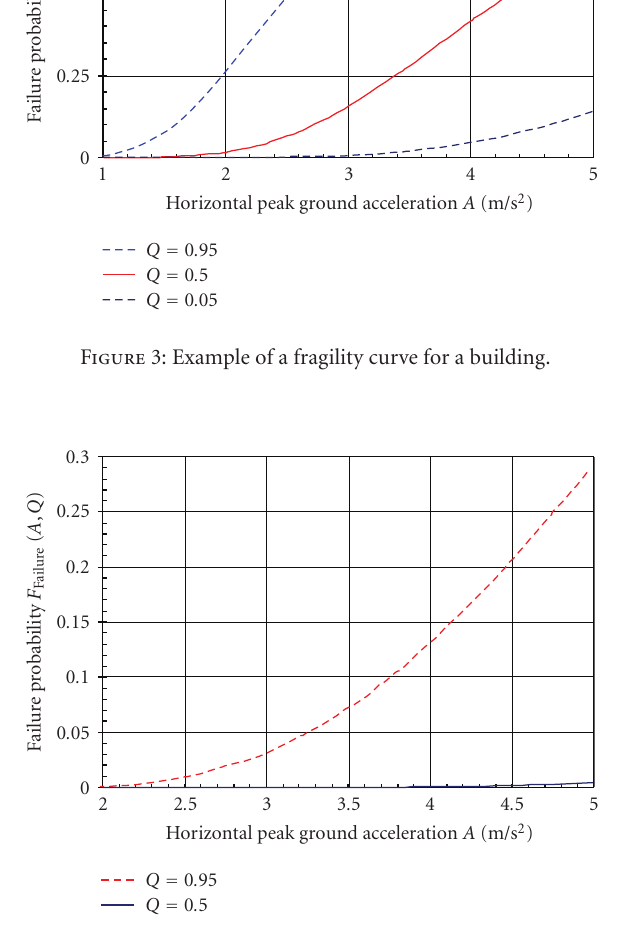
Figure 4: Example of a fragility curve for components, respectively for a